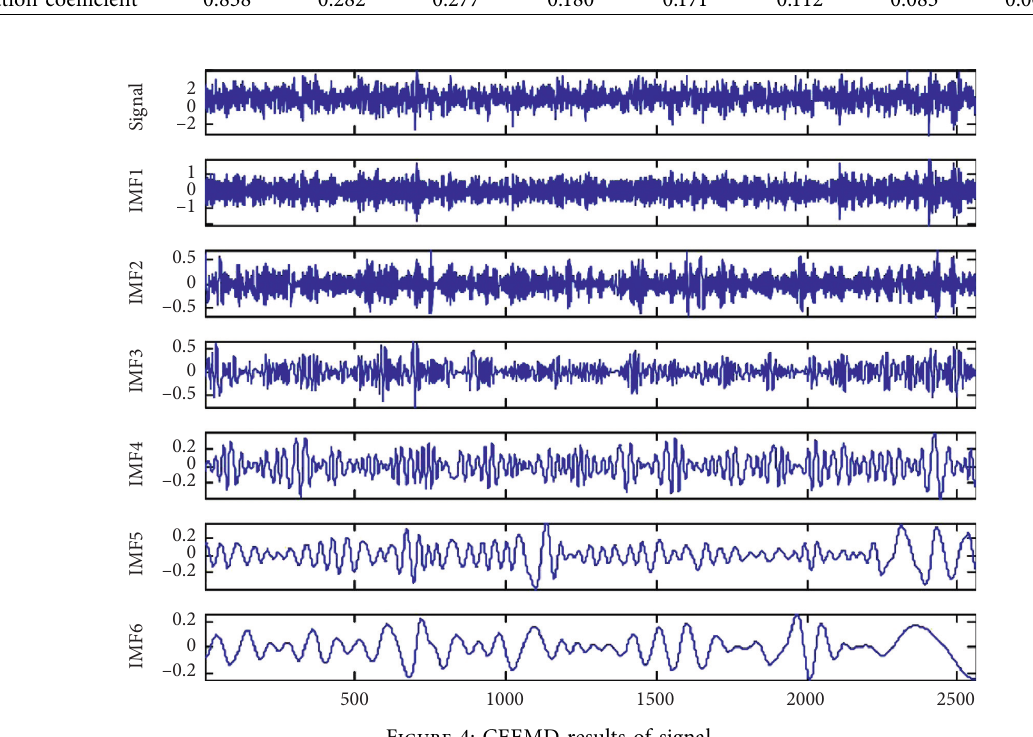
Figure 4: CEEMD results of signal.